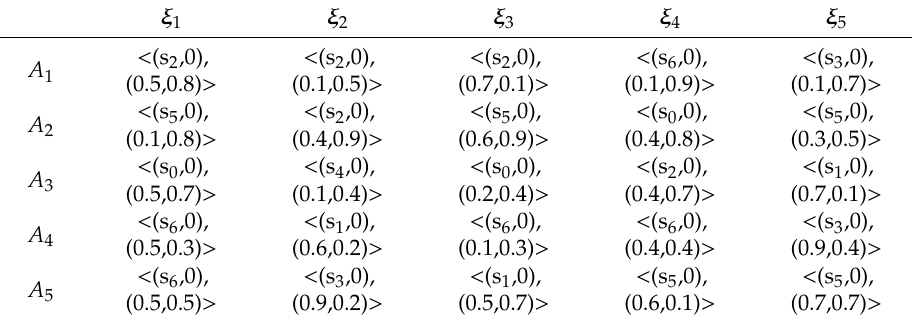
Table 2. P2TLN decision matrix by DM 2